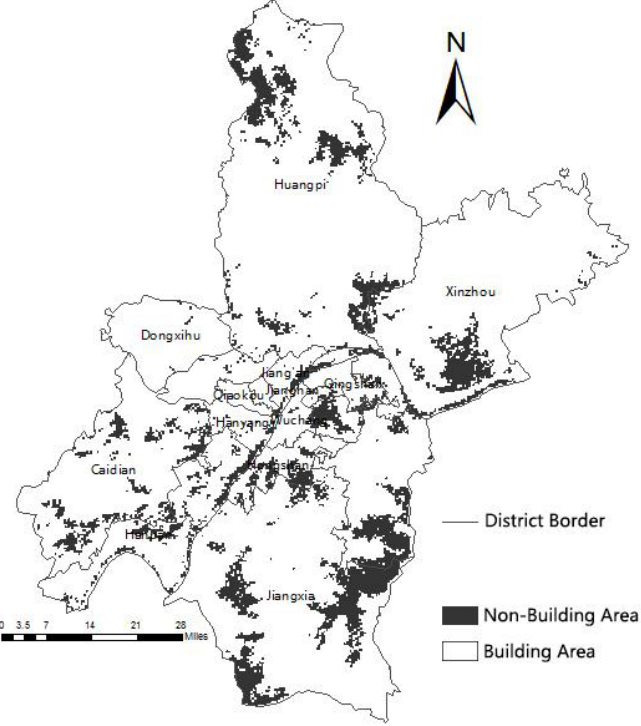
Figure 6. Unremoved non-building land location selection results. MCE = multi-criteria evaluation.